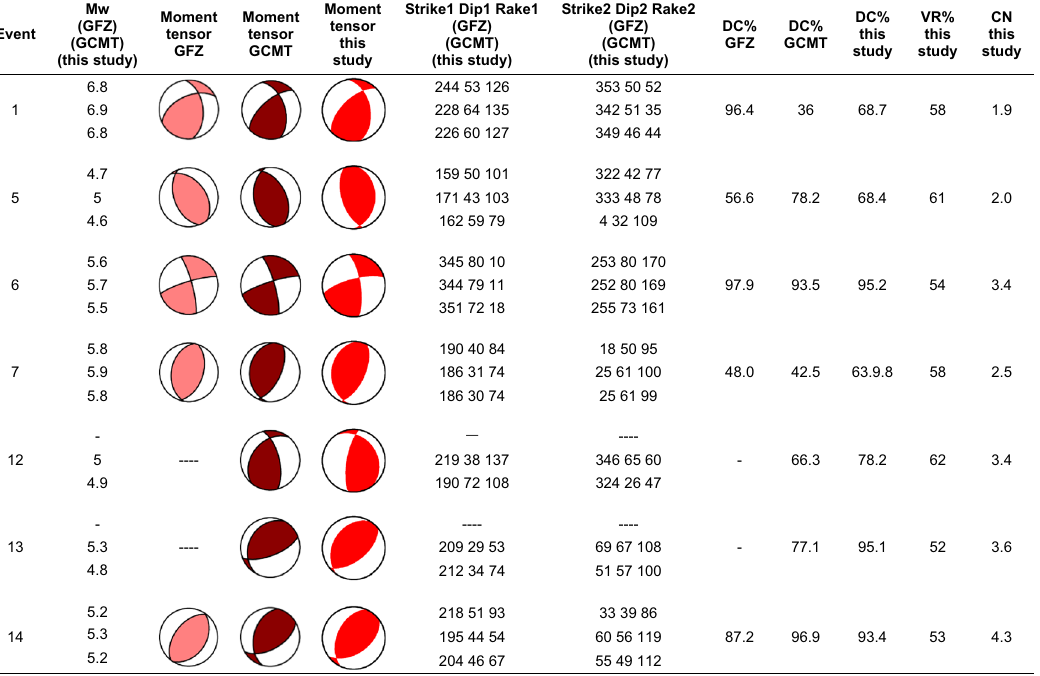
Table 3 Comparison of the moment tensor solutions derived from GFZ, GCMT, and this study Mw Moment Moment (GFZ) Event tensor tensor (GCMT) GFZ (this study)